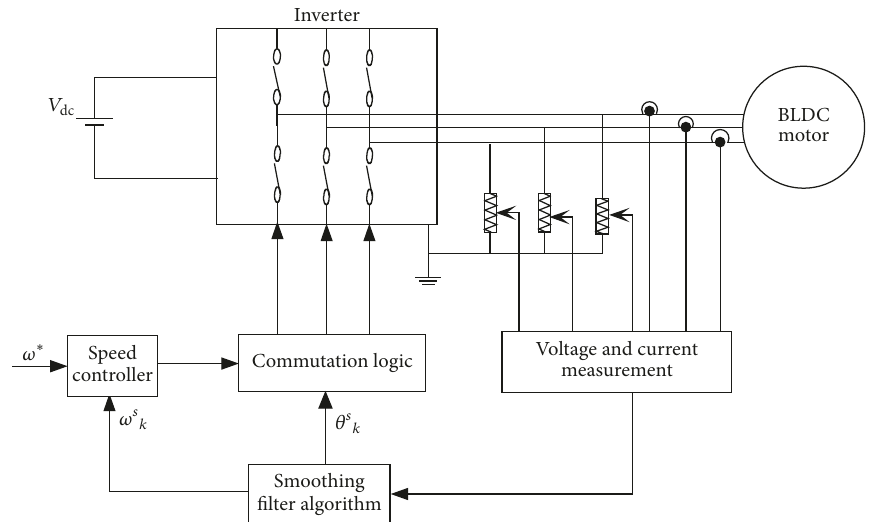
Figure 1: Block diagram for position and speed